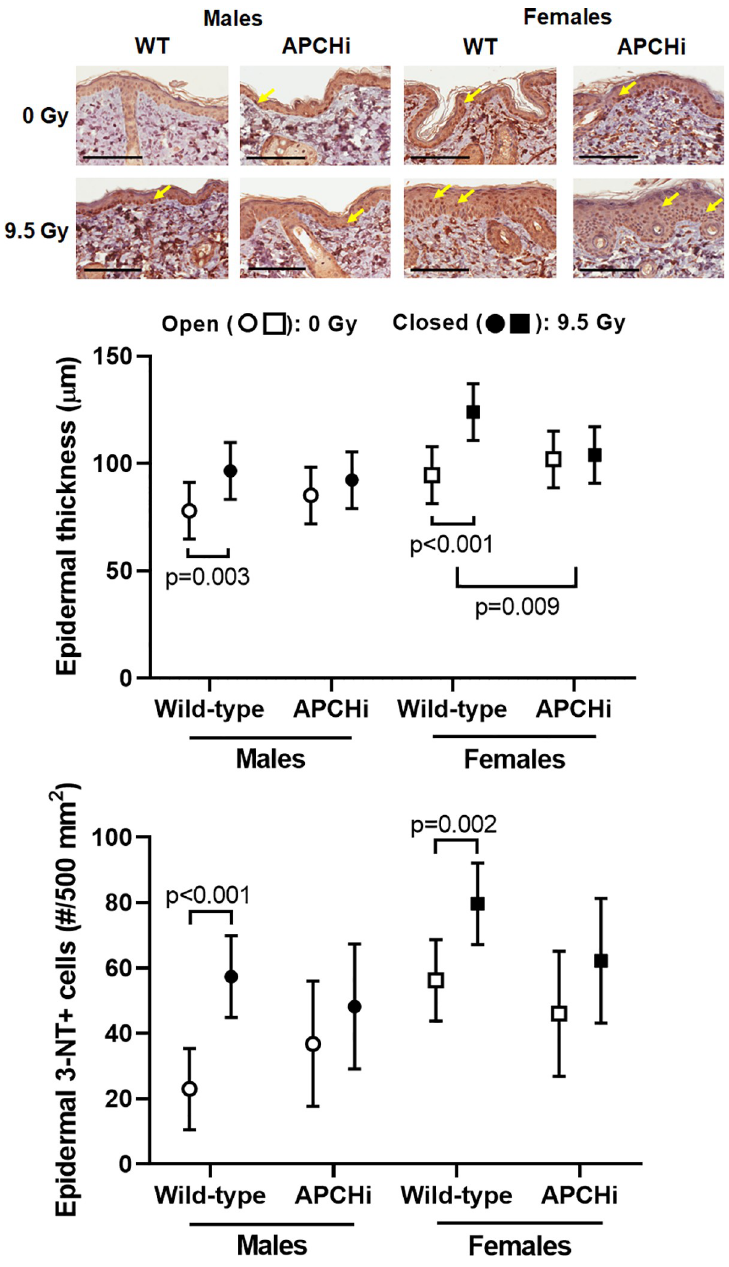
Fig 8. Epidermal thickness and number of 3-NT positive cells in the epidermis. Epidermal thickness was assessed in Hematoxylin & Eosin stained sections. Immunohistochemistry was used to detect 3-NT positive cells. 3-NT positive epidermal keratinocytes (arrows in micrographs) were counted. Scale bars: 100 μ m. Graphs indicate means and SD of the statistical model; n = 6–9 wild-type males in 0 Gy, 10 wild-type males in 9.5 Gy, 6–8 APCHi males in 0 Gy, 8–9 APCHi males in 9.5 Gy, 7–8 wild-type females in 0 Gy, 5–6 wild-type females in 9.5 Gy, 8–9 APCHi females in 0 Gy, and 8–9 APCHi females in 9.5 Gy. The short brackets indicate a significant difference between 0 Gy and 9.5 Gy. The wider bracket indicates that the effect of radiation in wild-type mice is significantly different from the effect of radiation in APCHi mice.